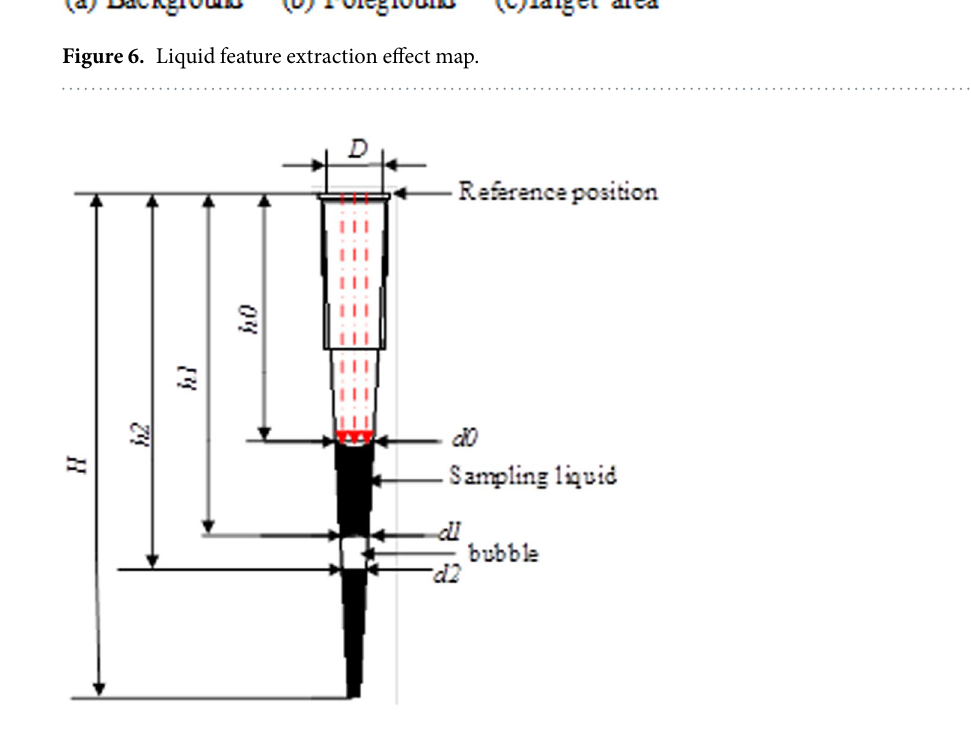
Figure 7. Calculation model of pipetting